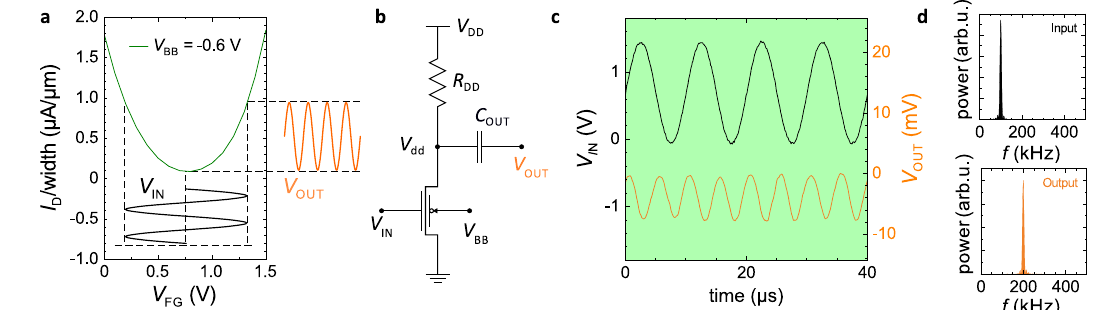
Fig. 3 | Frequency doubling utilizing the parabolic transfer characteristic in ambipolar mode. a Ambipolar transfer characteristics of the used BB-RFET when steered by V BB = – 0.6V at the backgate and a drain-source voltage of V DS =1.5V (green).Drawn-insinecurvesschematicallysymbolizetheinputandoutputsignals at the operation point. b Circuit diagram of the single transistor setup used for frequency manipulation. The output V OUT is capacitively coupled to the V dd node